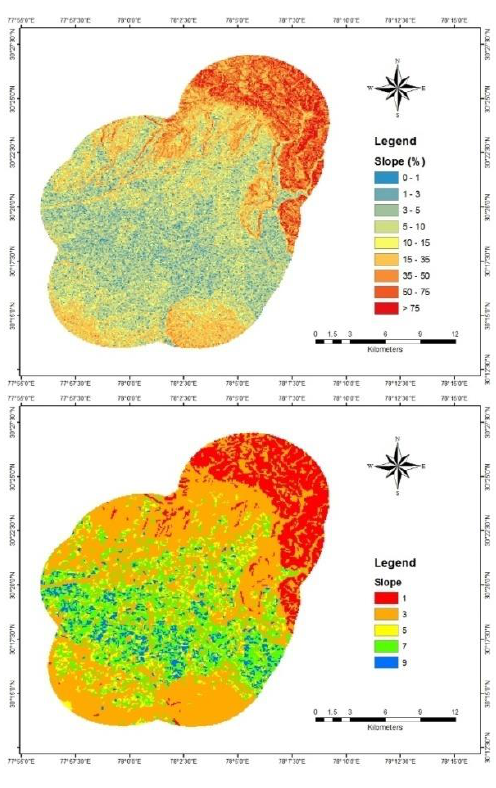
Figure 4. Slope Suitability